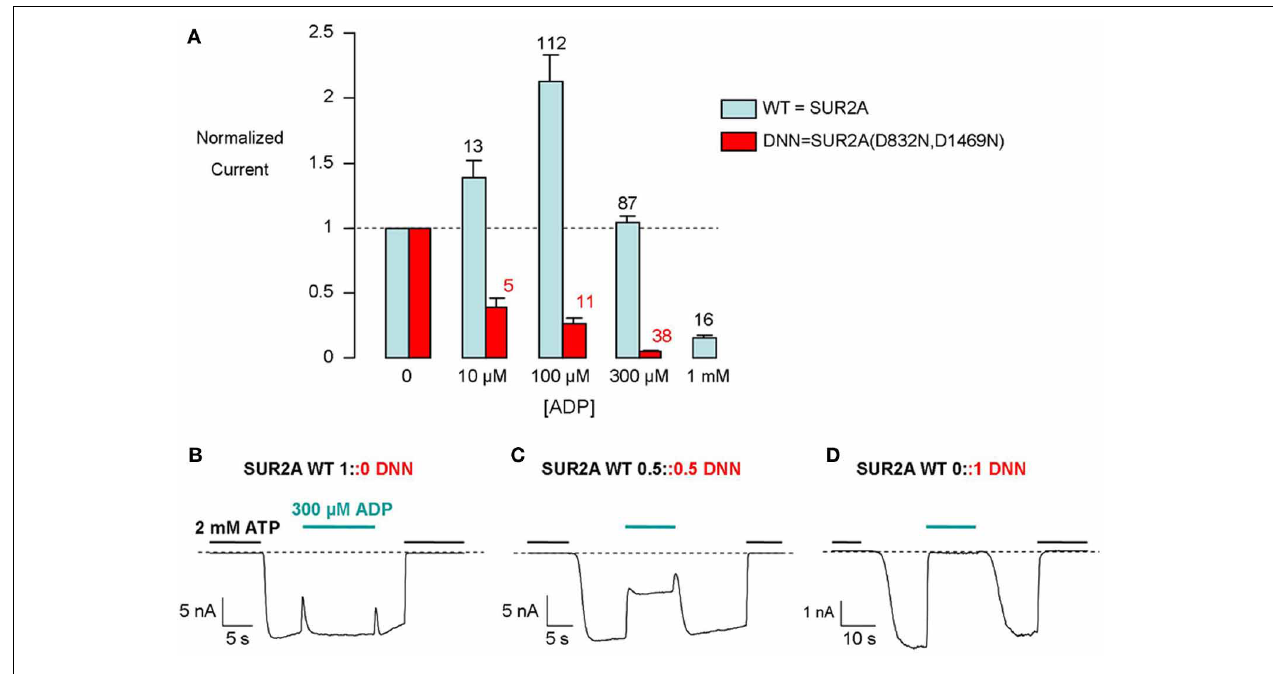
FIGURE 1 | Distinct responses of WT and mutant K ATP channels to 300 µ M ADP as an indicator of SUR-mediated ADP activation. (A) Concentration-dependent modulation by ADP of WT and mutant K ATP channel currents recorded from inside-out patches. Numbers above bars